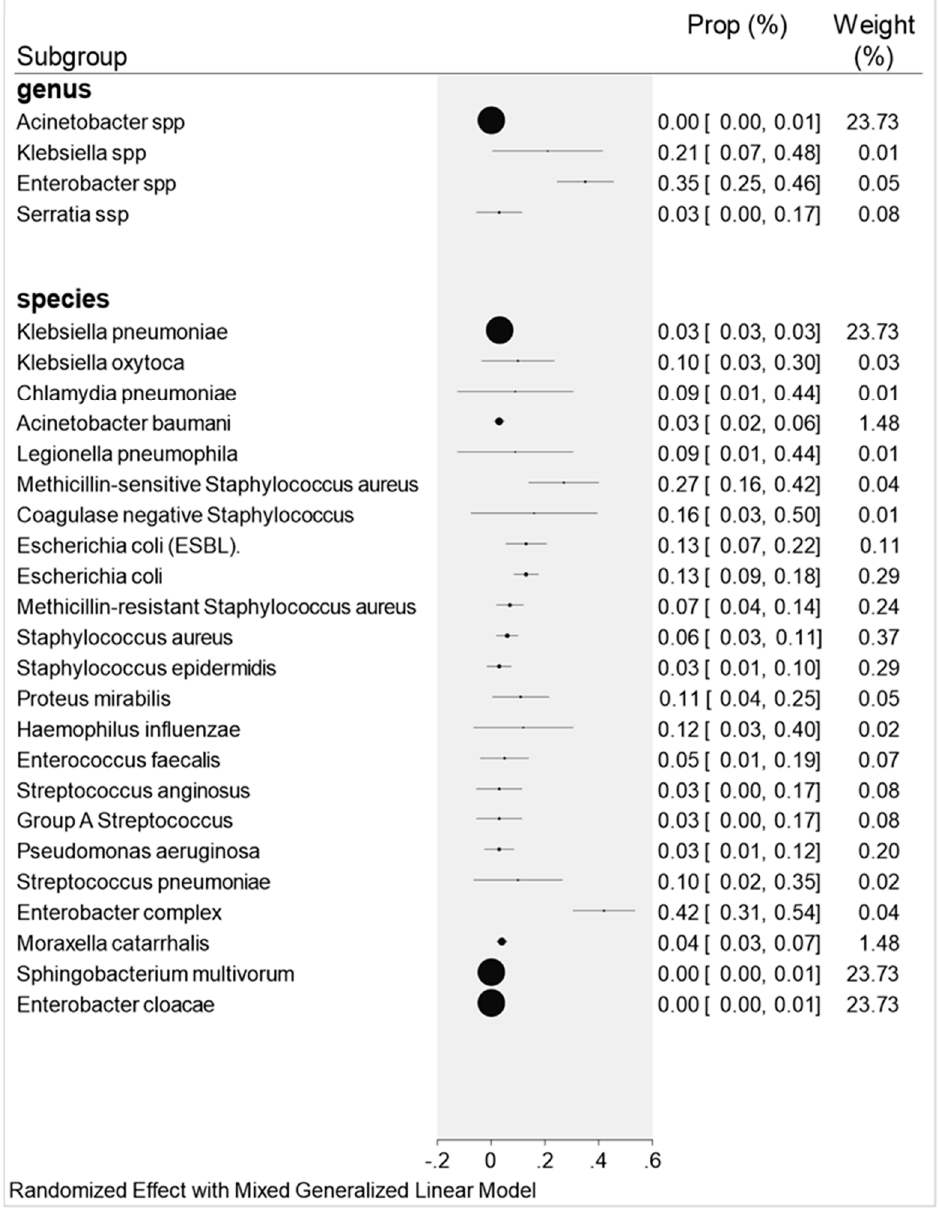
Figure 2. Forest plot graph: showing the subgroup (genus and bacterial species) and their respective proportions by co-infection .